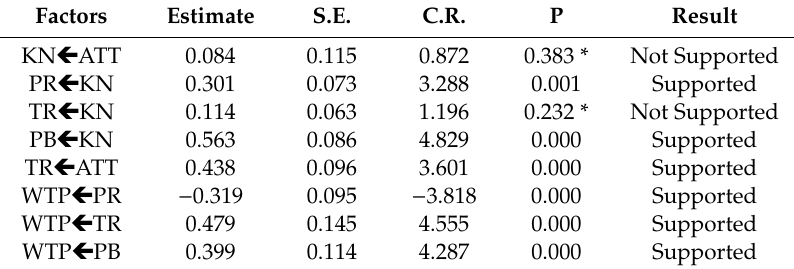
Table 5. Estimated regression weights of the structural model (Second Survey) Table 4. Estimated regression weights of the structural model (First Survey) Table 4. Estimated regression weights of the structural model (First Survey) Table 4. Estimated regression weights of the structural model (First Survey) Table 4. Estimated regression weights of the structural model (First Survey) Table 4. Estimated regression weights of the structural model (First Survey) Table 4. Estimated regression weights of the structural model (First Survey) Table 4. Estimated regression weights of the structural model (First Survey) Table 4. Estimated regression weights of the structural model (First Survey)